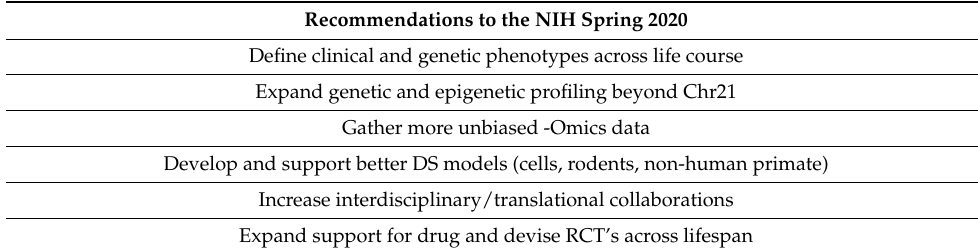
Table 3. Recommendations for future research to the NIH. Eleven groups discussed and finalized